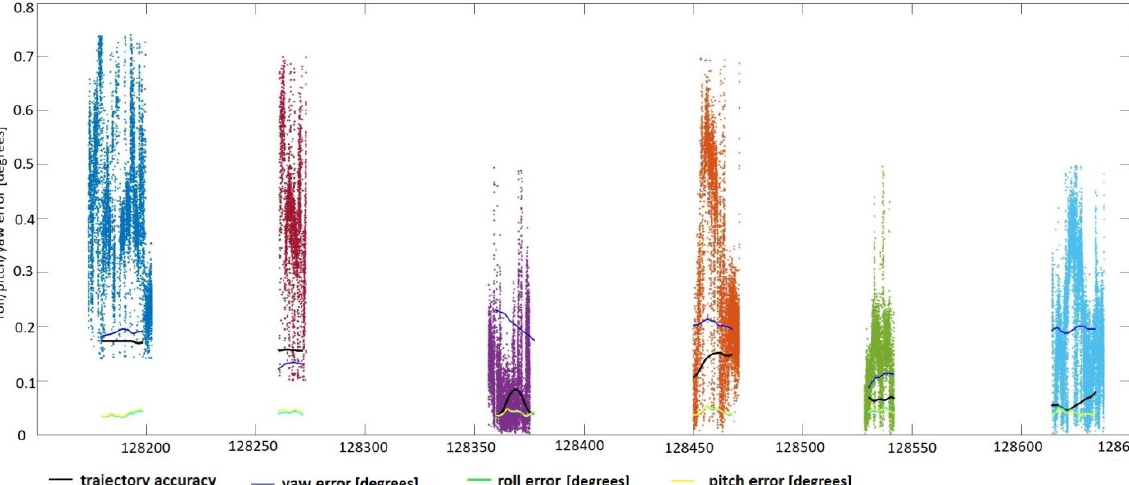
Figure 8. The relation between trajectory accuracy and the differences between the DIM cloud and ULS cloud presented for individual strips with respect to